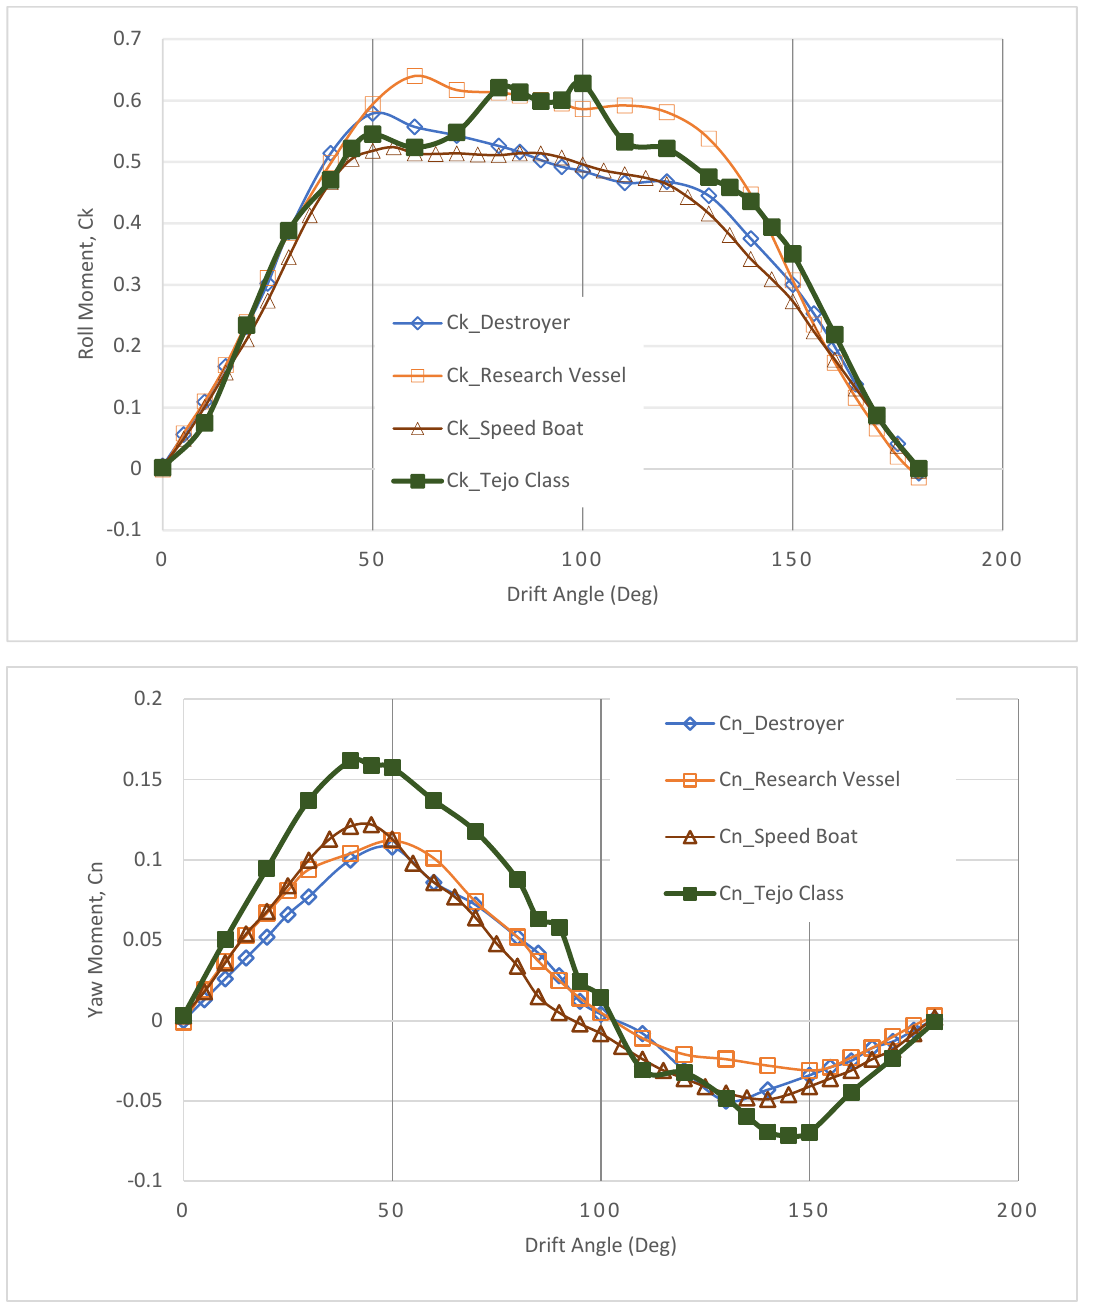
Figure 16. Relative comparison among moment results for the Tejo vessel and three other ship models from Blendermann [13].